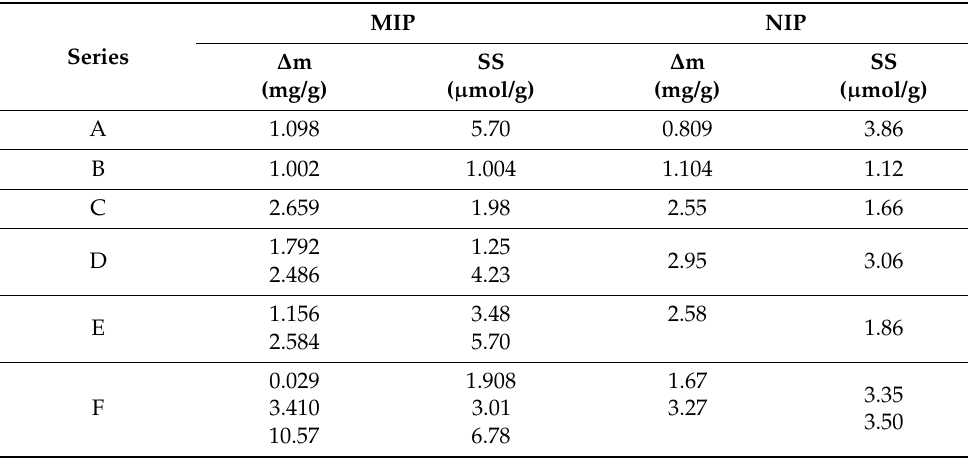
Table 2. Sorption properties of imprinted membranes.